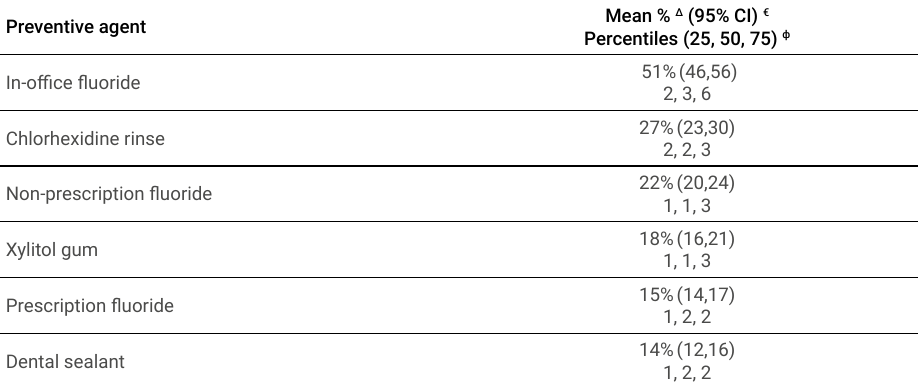
Table 3. Mean percent of adult patients within a practice who receive each caries preventive agent. Preventive